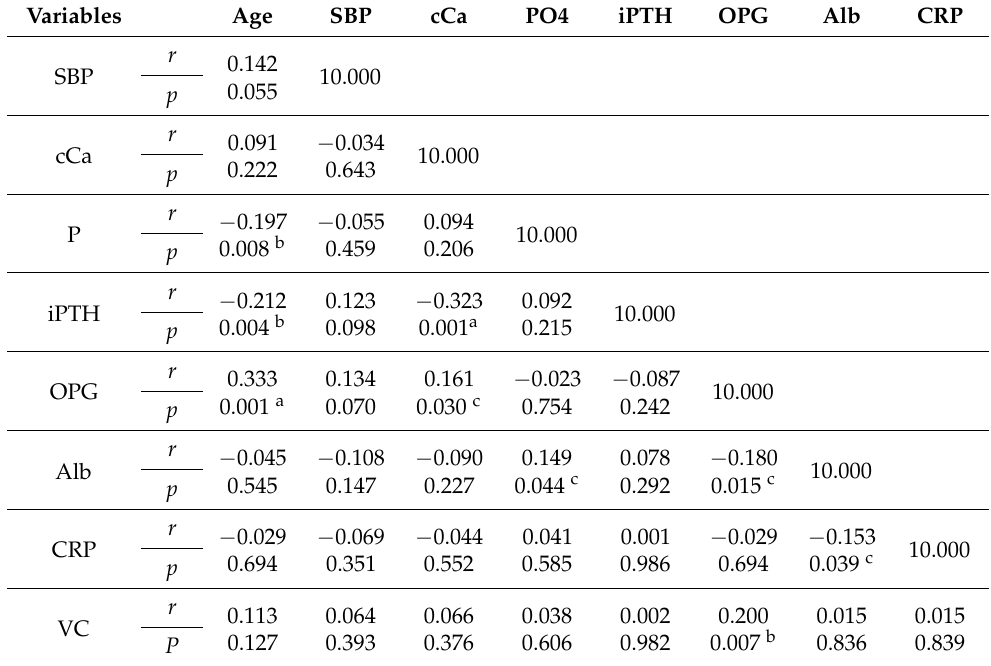
Table 2. Multiple correlations between variables adjusted by diabetes. Variables Age